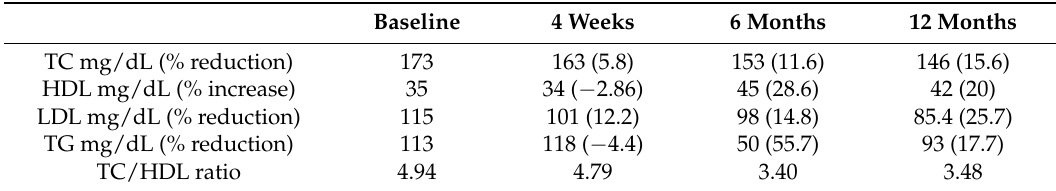
Table 1. Serum lipid profile of the patient at baseline and during follow-up after the introduction of apremilast. The percentage of reduction/increase of the serum levels are